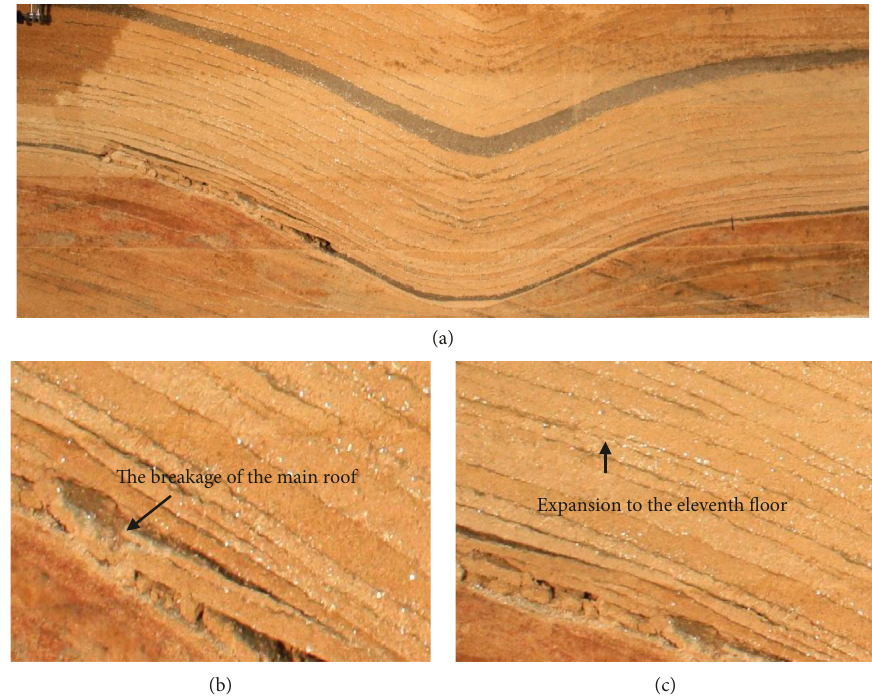
Figure 7: Periodic pressure of the main roof. (a) The whole picture of the model after the breakage of the main roof. (b) The breakage of the main roof. (c) Separation of the overlying